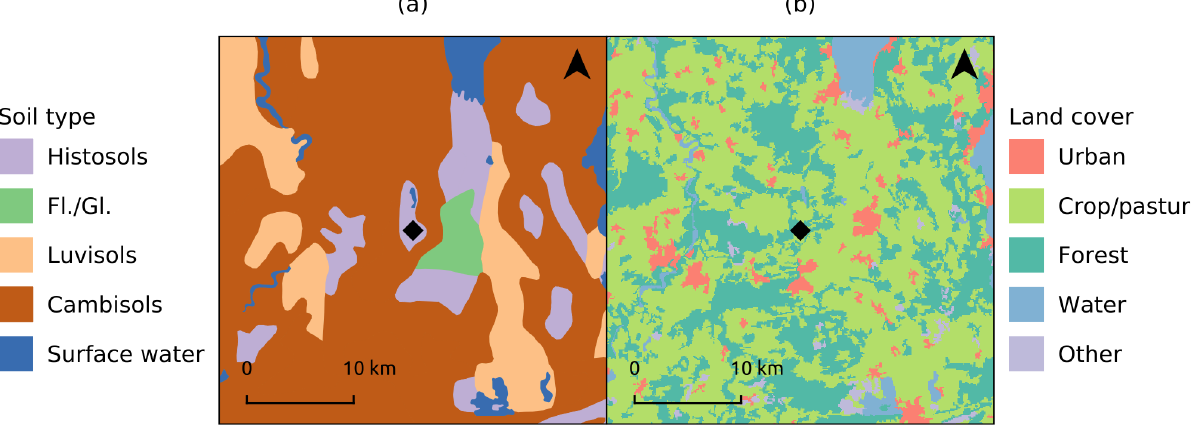
Figure 2. (a) Soil types in the region around the Fendt site, based on BGR (2013), denoted in WRB classification (IUSS Working Group WRB, 2015). “Fl./Gl.” stands for “Fluvisols/Gleysols”. (b) Simplified land cover map (CORINE 2012 v18.5, European Environment Agency, EEA, 2016) of the same region. In both panels the location of the Fendt site is marked with a black